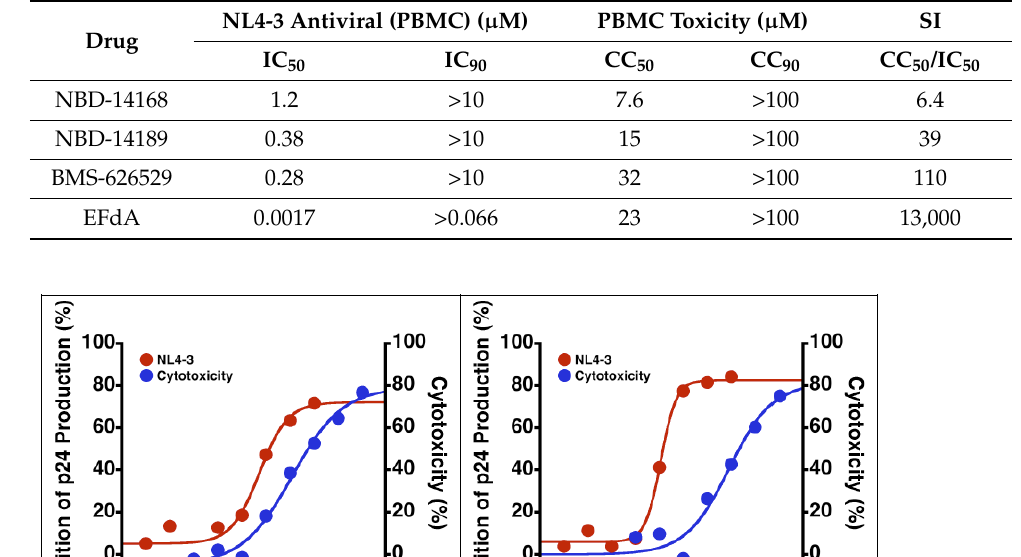
Table 4. Antiviral activity against HIV-1 NL4-3 in PHA-stimulated human PBMCs.